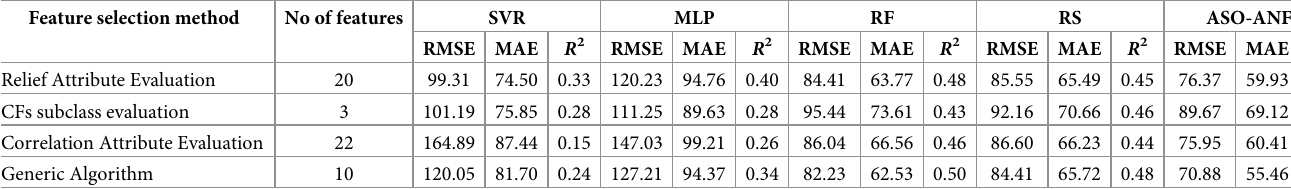
Table 5. Statistical indicators from machine learning models by using the validation dataset.